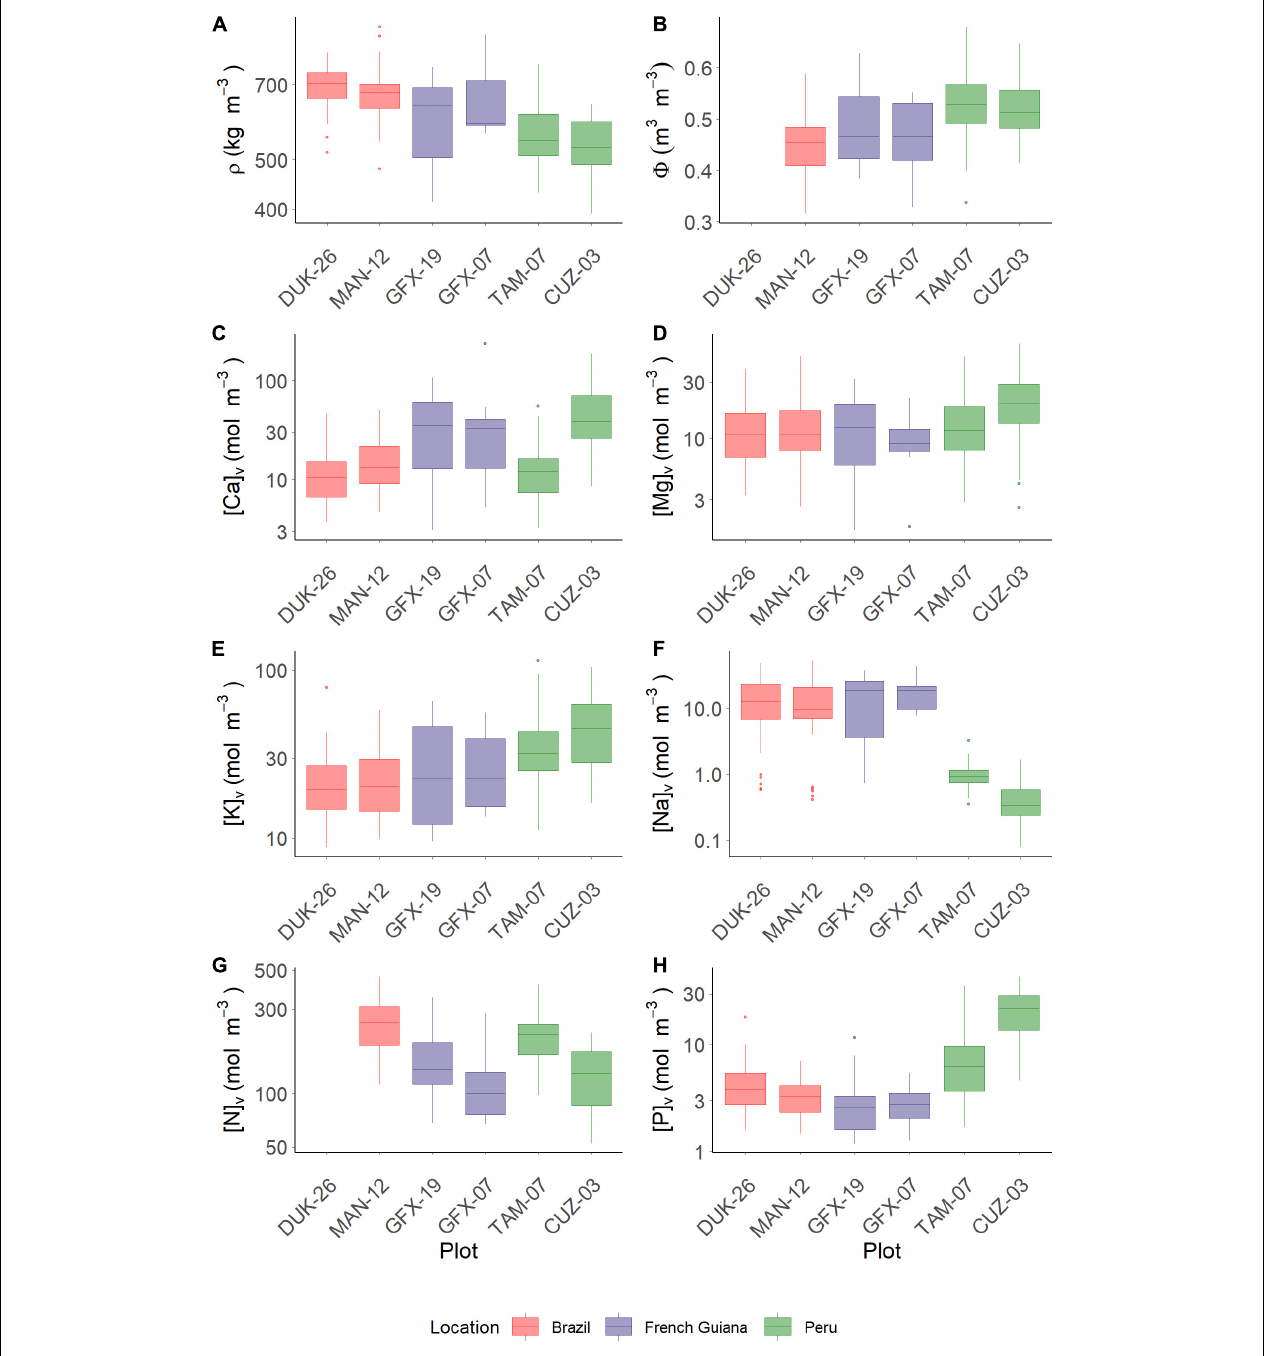
FIGURE 2 | Variation of traits in each studied plot. (A) Wood density ( ρ ). (B) Water content per unit tissue volume ( (cid:56) ). (C) Calcium. (D) Magnesium. (E) Potassium. (F) Sodium. (G) Nitrogen. (H) Phosphorus. Data on (cid:56) and N are not available for DUK-26.